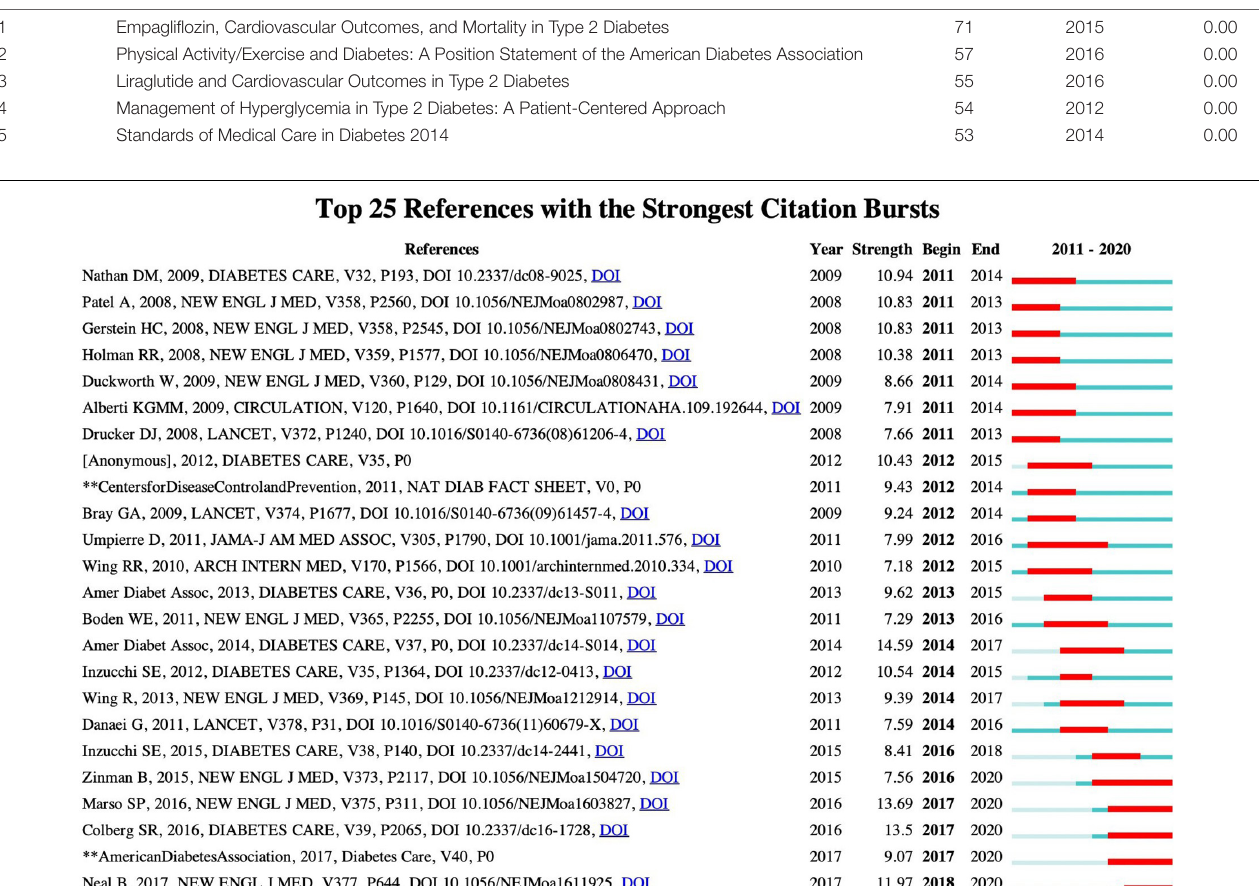
Physical Activity/Exercise and Diabetes: A Position Statement of the American Diabetes Association